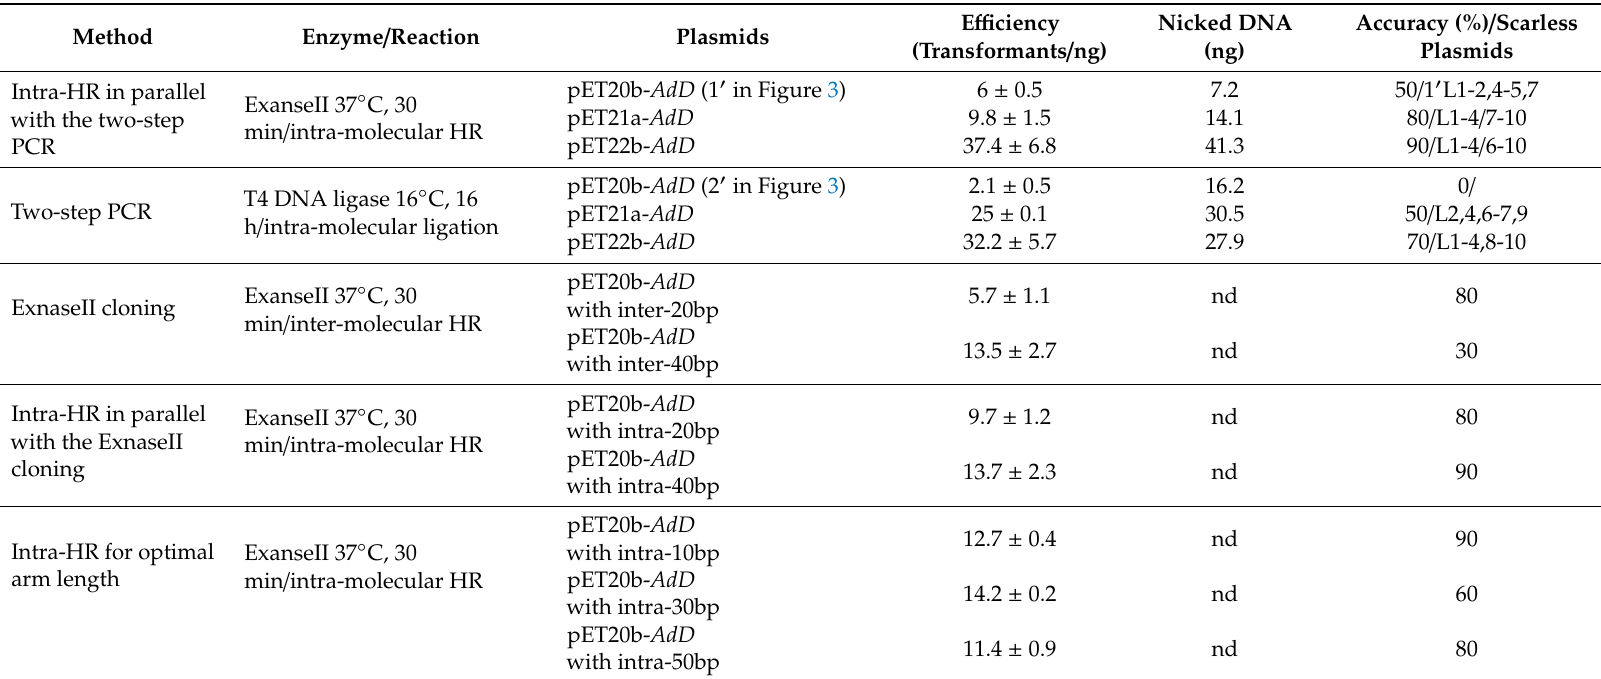
Table 1. Summary of the intra-HR, the two-step PCR, and the ExnaseII